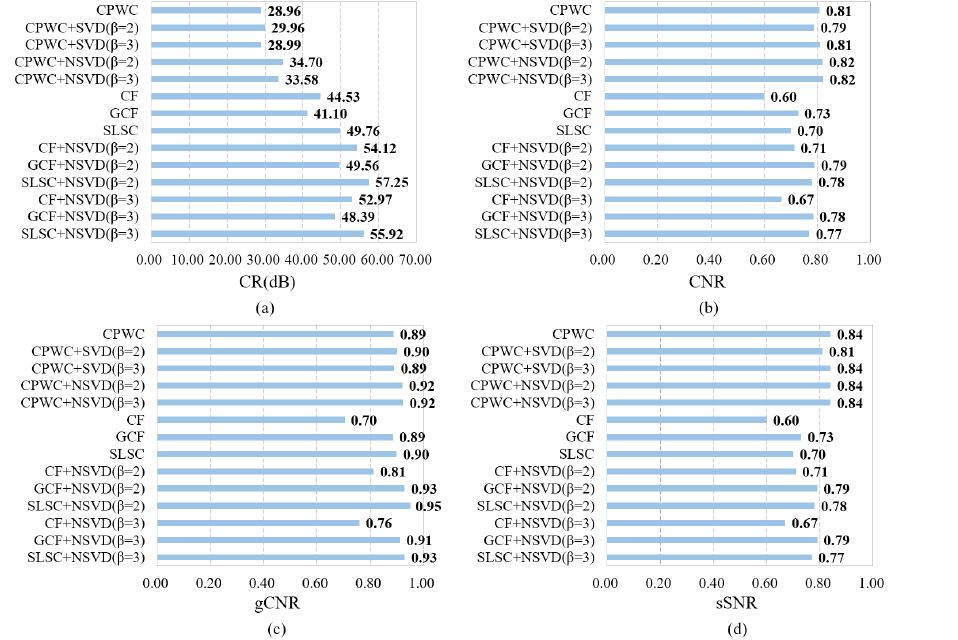
Figure 15. ( a ) CR, ( b ) CNR, ( c ) gCNR, and ( d ) sSNR for each beamforming method in in vivo